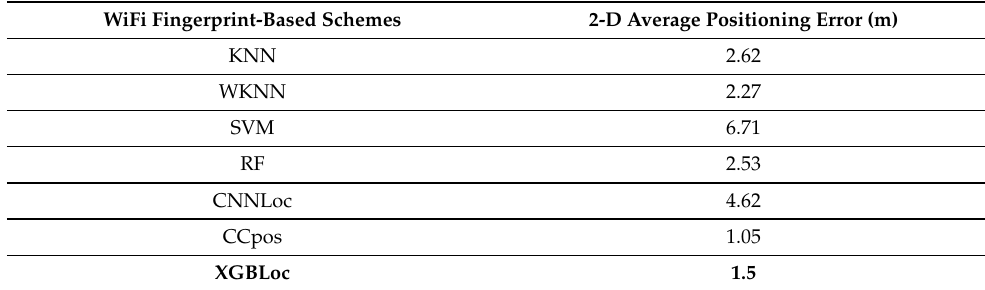
Table 10. Regression results of existing and proposed schemes on the Alcala